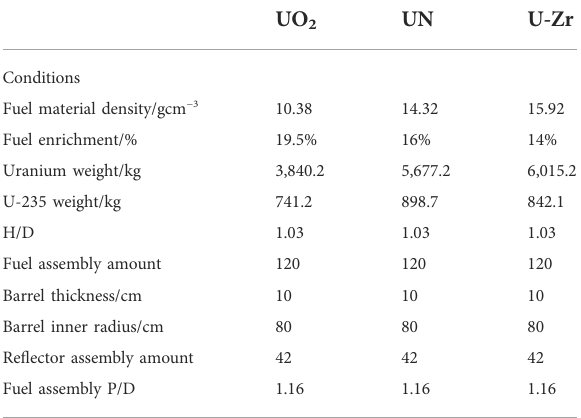
TABLE 6 Conditions of the fuel material analysis.